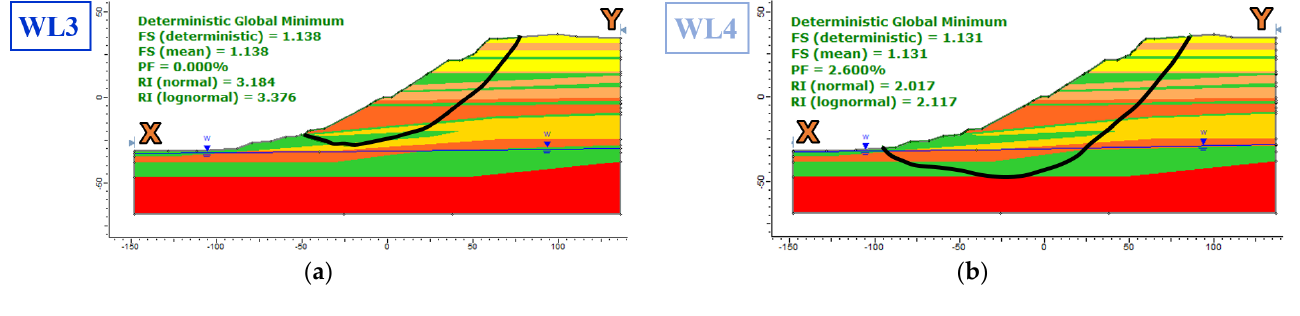
Figure 10. Janbu simplified, complex shaped slides from Rocscience Slide2 software. ( a ) Results for WL3 modeled water level, considering the minimum values of water levels measured in 2020; ( b ) Results for WL4 modeled water level, taking into account the maximum values of water levels measured in 2020.